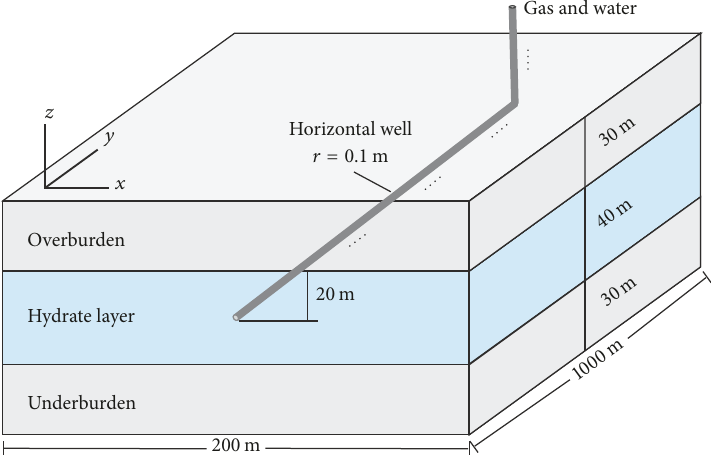
Figure 2: Model geometry and the configurations of horizontal